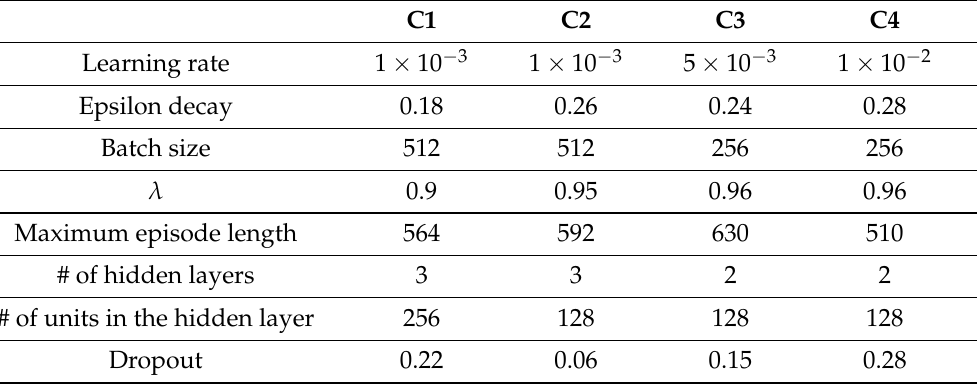
Figure 7. Agent learning progress for different hyperparameter configurations. Table 6 shows the corresponding combination values. Table 6. Hyperparameter configurations used in the experiment of Figure